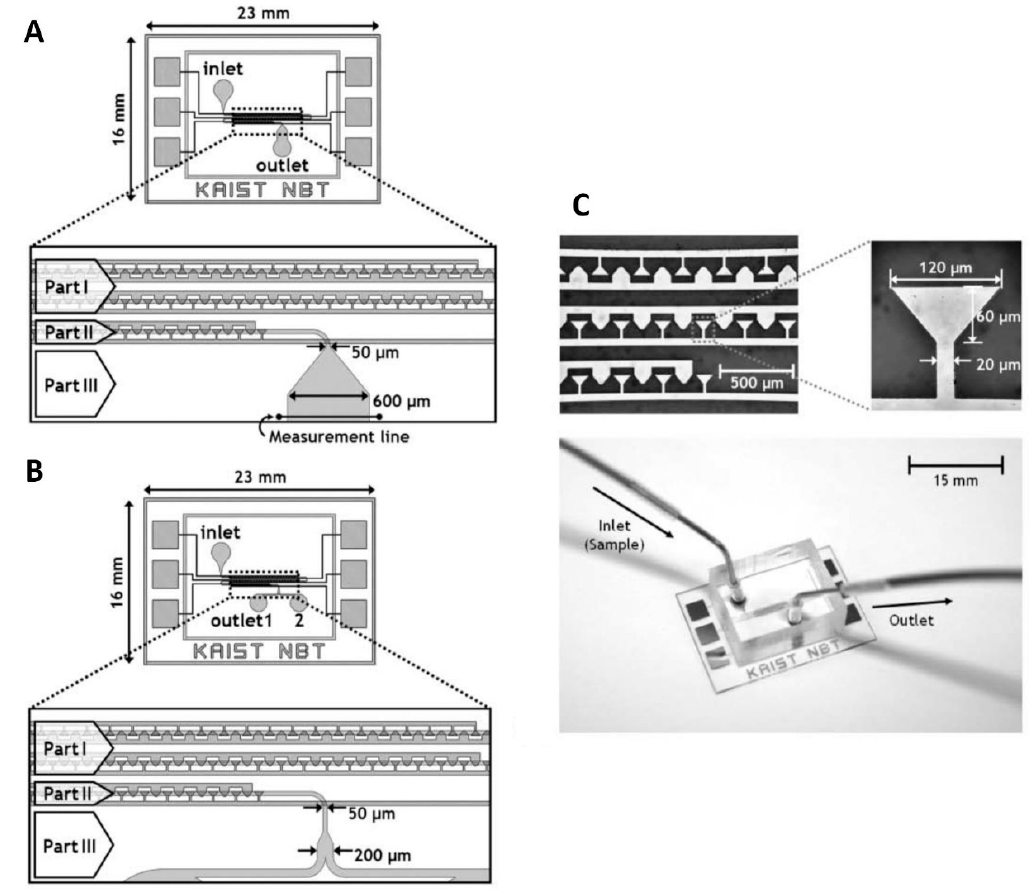
Figure 8. A trapezoidal electrode array (TEA) microfluidic chip. Reproduced with permission from [78], © 2005 RSC. ( A ) Schematic of the chip for particle separation. ( B ) Schematic of the chip for particle fractionation. ( C ) Image of the TEA and the device.